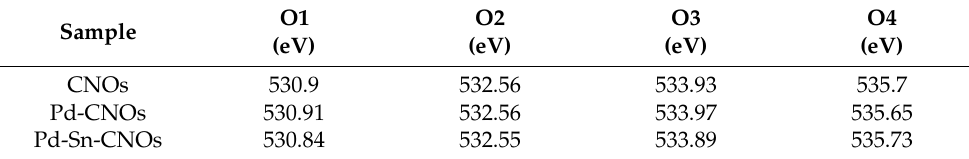
Table 4. Binding energies (in eV) of the four components of the O 1s core level for CNO samples.